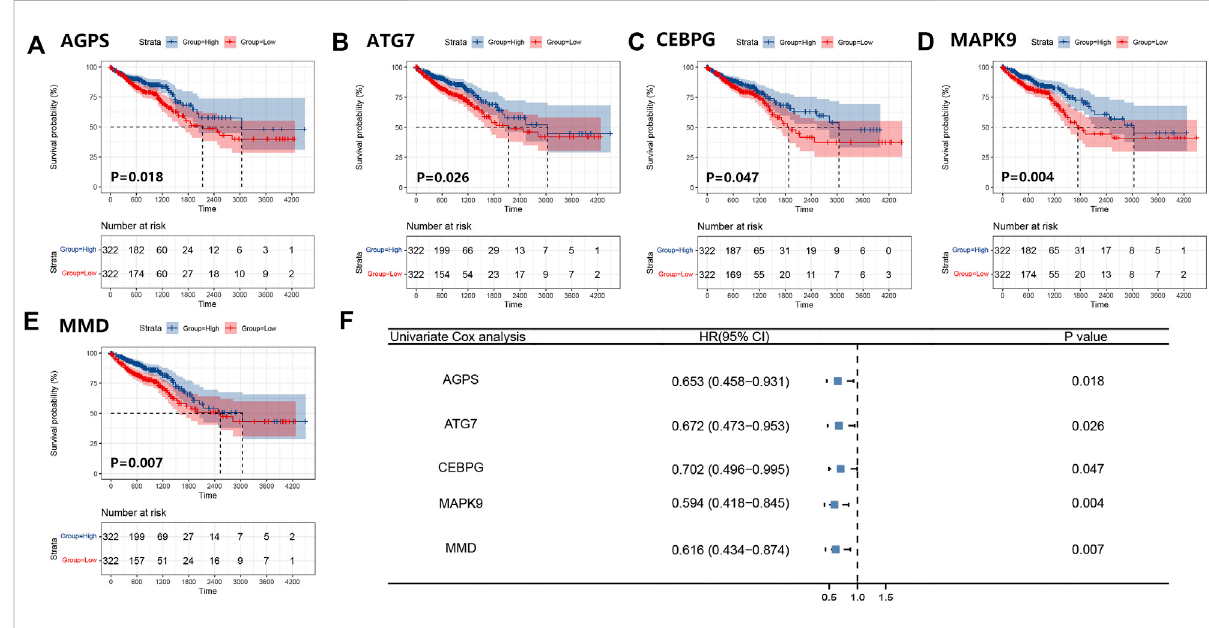
FIGURE 3 Survival curves of fi ve ferroptosis-related prognostic genes and the forest map of univariate Cox regression analysis. (A – E) Kaplan-Meier plots showed the ferroptosis-related genes AGPS (A) , ATG7 (B) , CEBPG (C) , MAPK9 (D) , and MMD (E) with prognostic value. (F) The result of the univariate Cox regression analysis was presented by forest map.